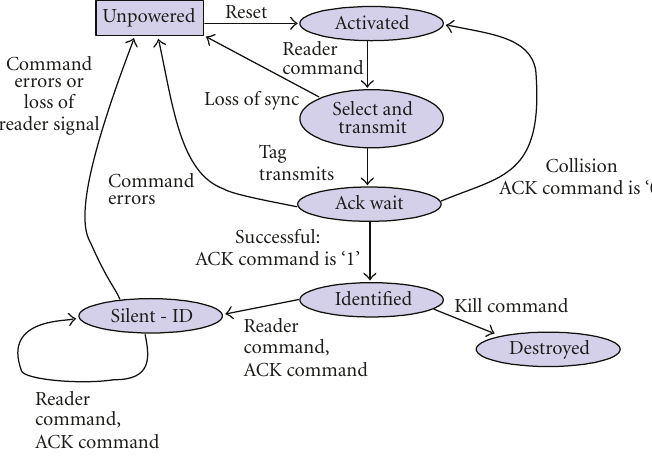
Figure 2: ASAP: tag state